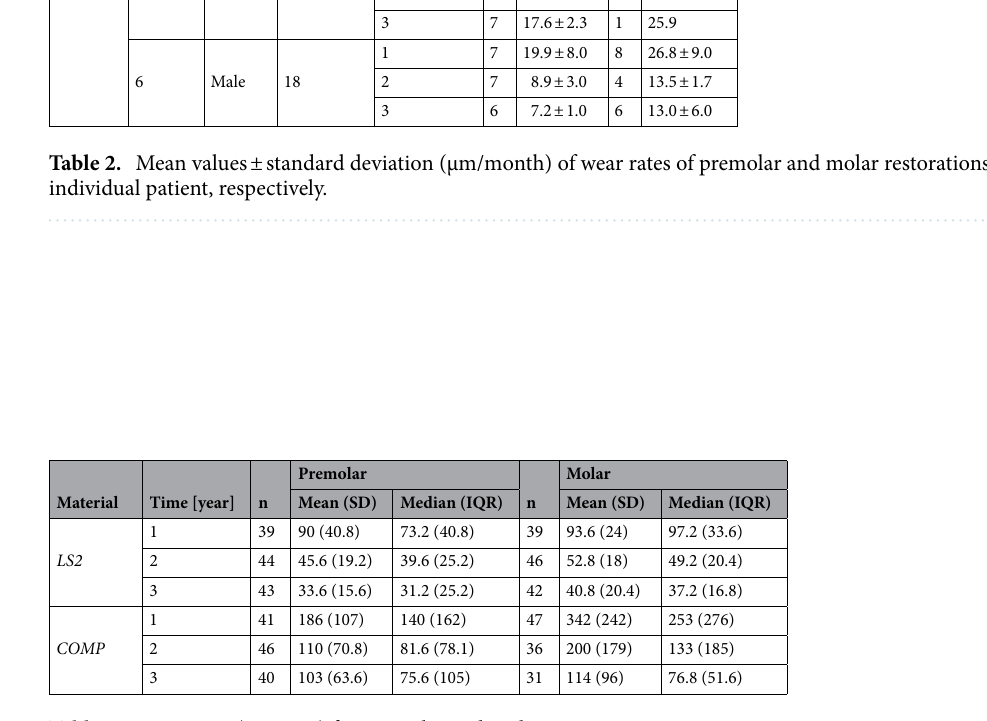
Table 3. Wear rates (µm/year) for premolar and molar